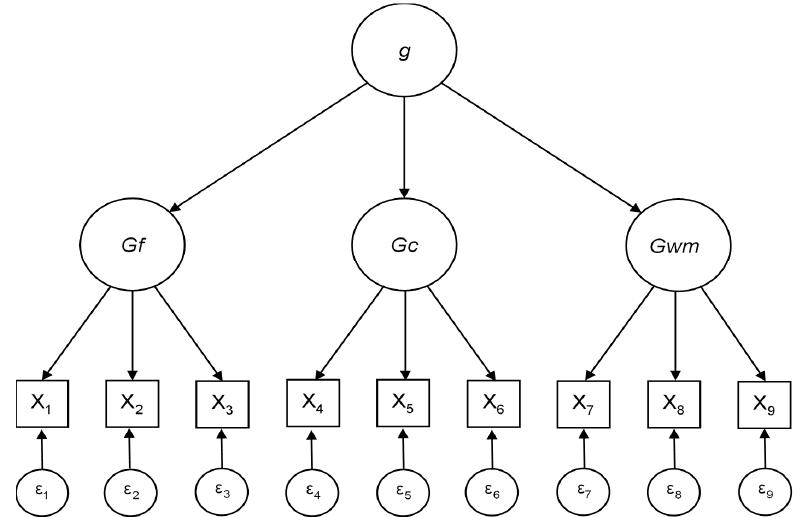
Figure 1. Example latent variable model: Higher-order model of intelligence based on Cattell–Horn– Carroll hierarchical model of general intelligence. Adapted from “Human cognitive abilities: A survey of factor-analytic studies” by Carroll [18]. Circles represent latent variables: general cognitive ability ( g ), fluid intelligence ( G f ), crystallized intelligence ( G c ), and working memory ( G wm ). Smaller circles presented at the bottom of the display represent measurement error ( ε i ) or random noise not explainable by latent variables.